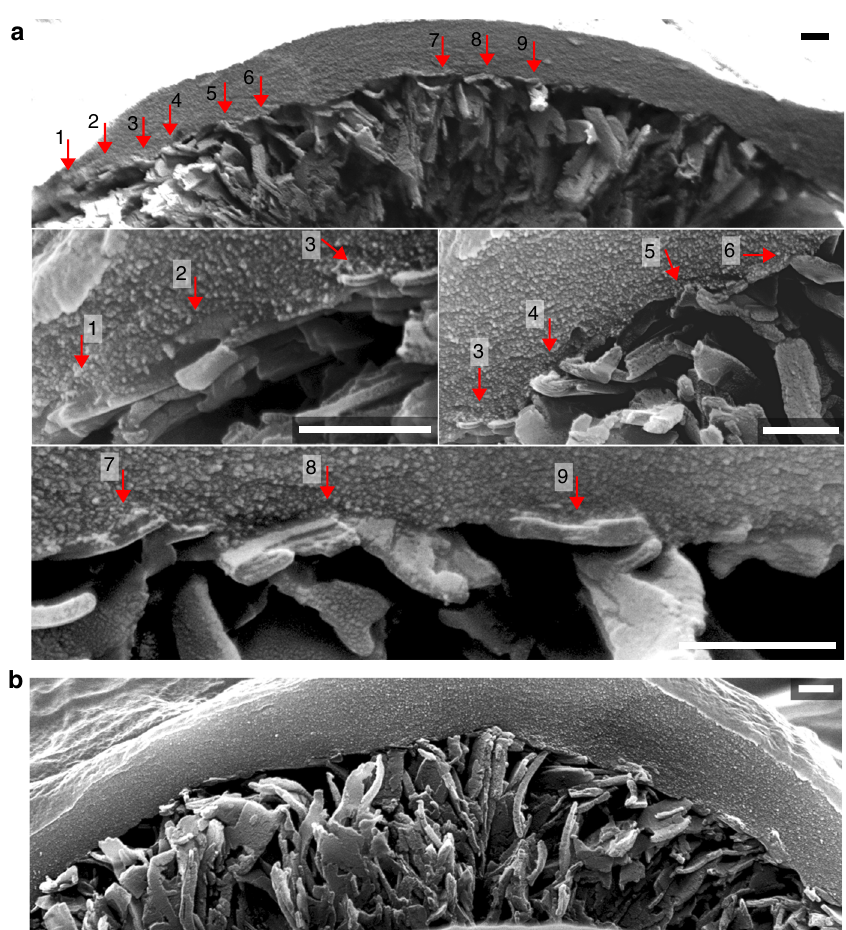
Fig. 6 Cross-sectional interface of cells and hedgehogs imaged with SEM. a An interface between a HEK cell and nanodagger hedgehog, with close contacts between cell membrane and nanocrystallites labelled and shown in higher magni fi cation. b Cross-section overview of another HEK/nanodagger interface, clearly showing the extent of distortion and crumpling of the nanodagger assembly under the cell. Scale bars = 500